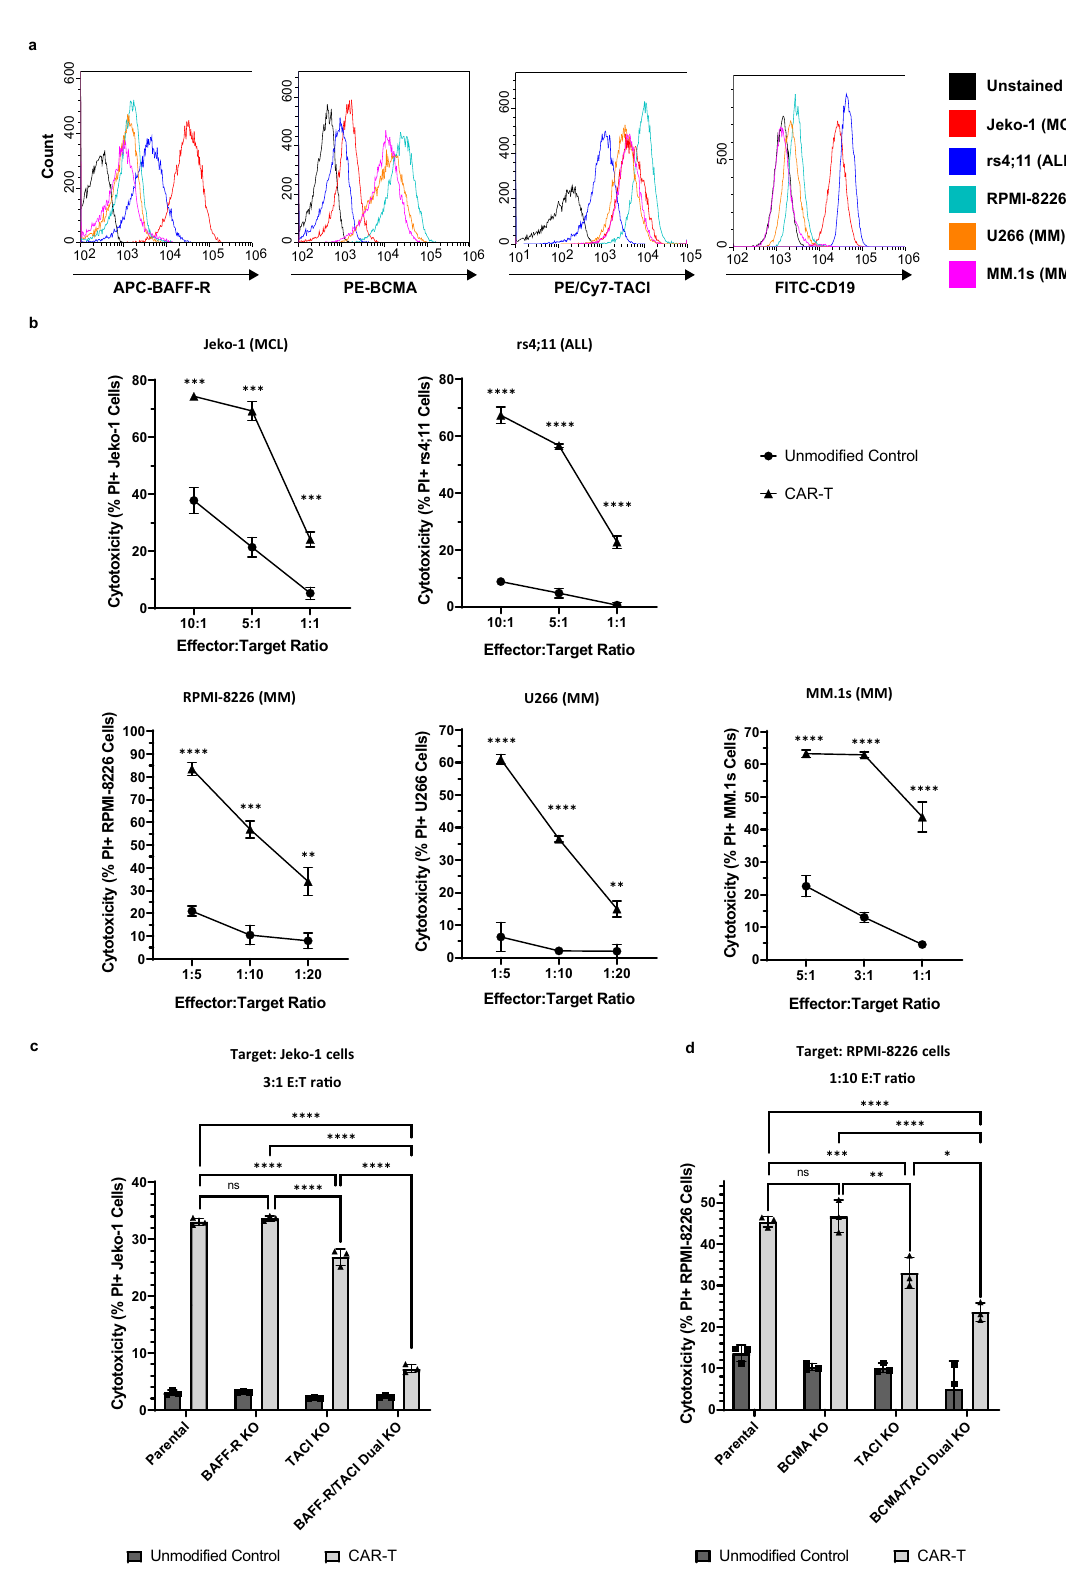
signi fi cantly higher levels of IL-2 compared to control (Supple- mentary Fig. 4d). In vivo cytotoxicity of BAFF CAR-T cells against MCL liquid cancer . We analyzed the effect of BAFF CAR-T against a liquid MCL xenograft model by using Jeko-1 cells that were modi fi ed to NATURE COMMUNICATIONS| (2022) 13:217